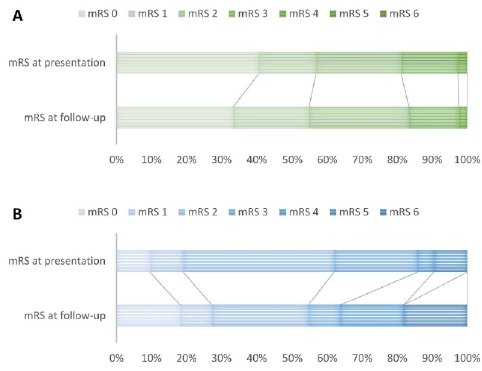
Figure 3. Distribution of the proportions of modified Rankin Scales (mRS) for ( A ) surgically treated